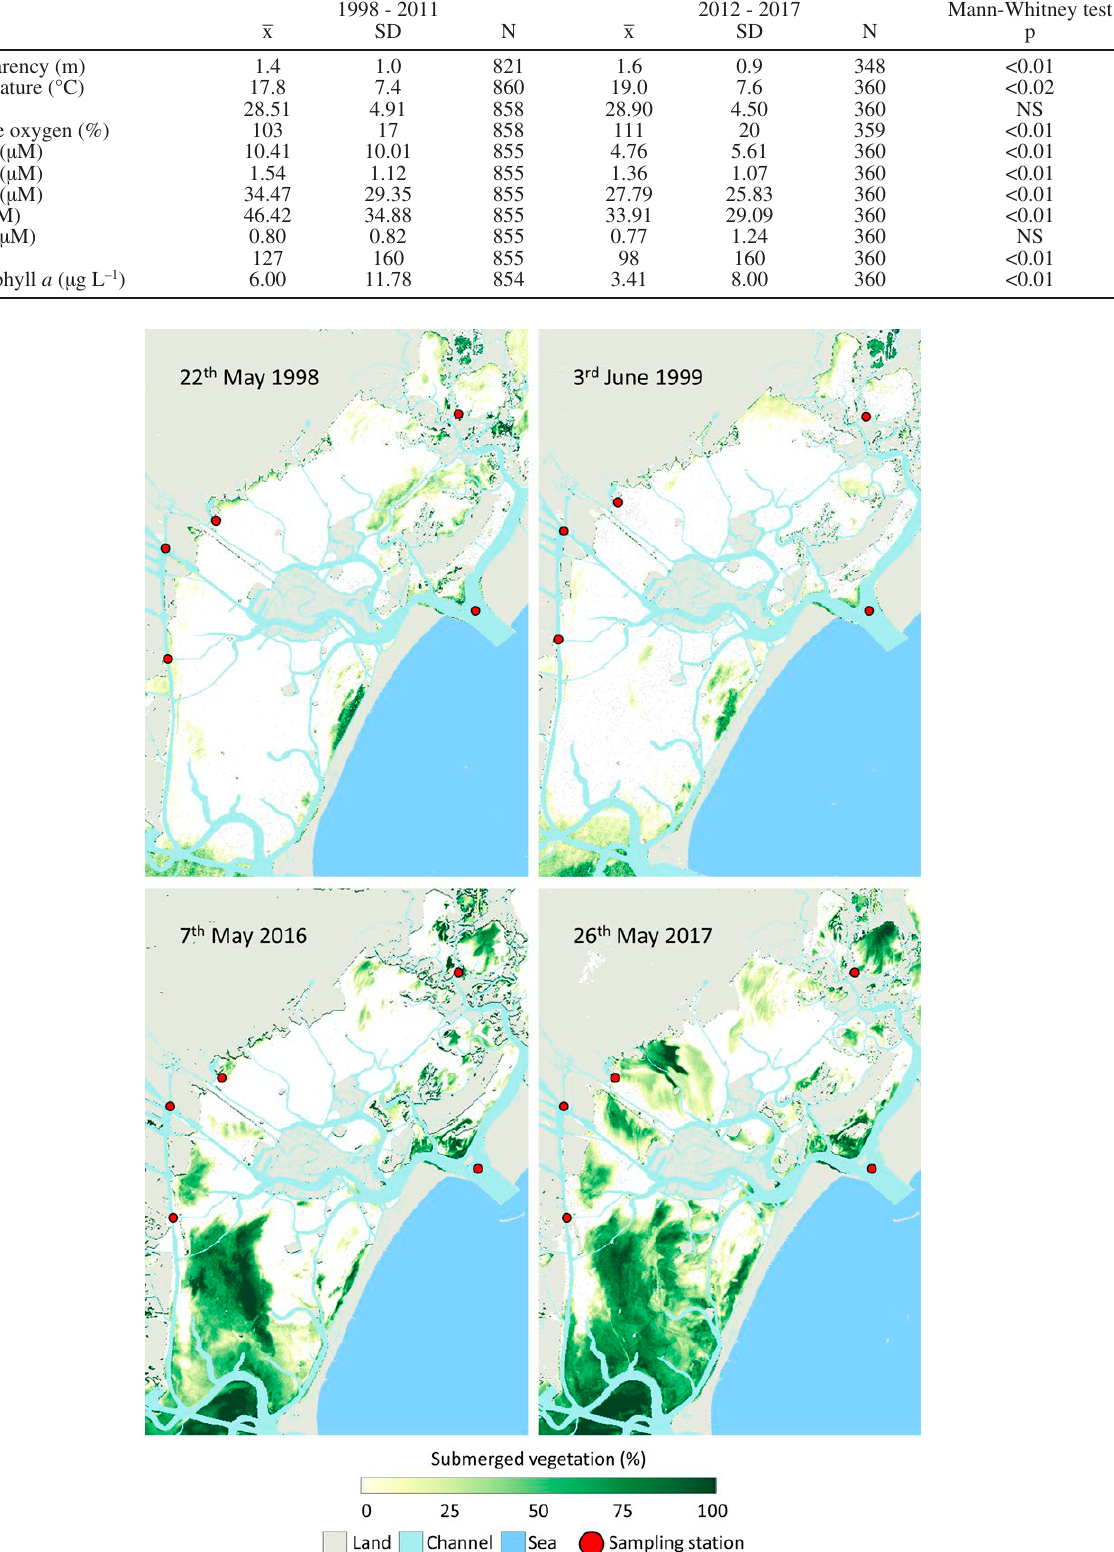
Fig. 6. – Spatial distribution of macrophyte coverage (seagrasses and macroalgae) in the central and northern lagoon in spring (22 May 1998, 3 June 1999, 7 May 2016 and 26 May 2017). The maps were derived from Landsat satellite images and processed as reported in Giardino et al. (2014) and Ghirardi et al.